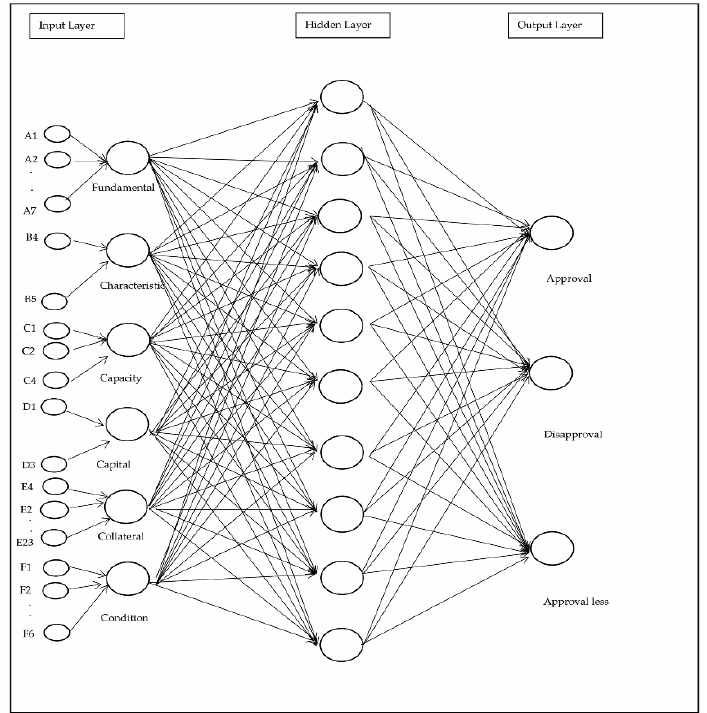
Figure A6. Structure of the NN by using Pareto technique ( 80 :20) model used for predicting.